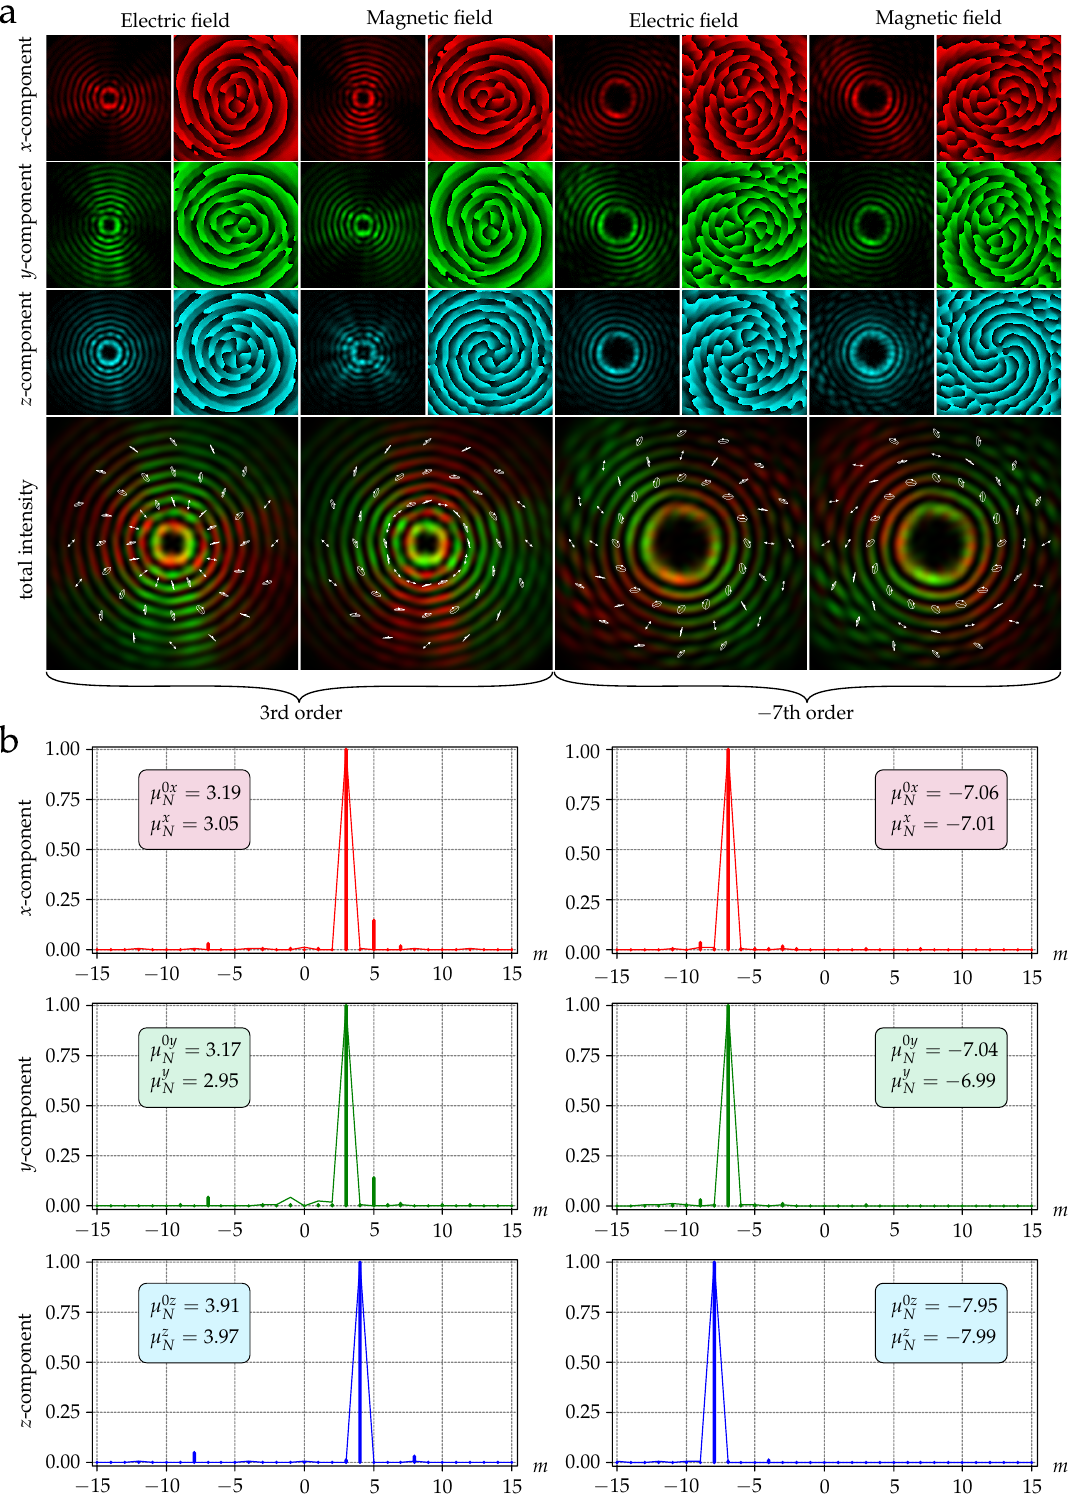
Figure 9. ( a ) Distribution patterns of the emitted fields in far-field. The size of the field plots is 2 mm × 2 mm. ( b ) Normalized intensities of the expansion coefficients in the basis of angular harmonics (OAM spectra) of the components of the electric field 1 (left column) and field 2 (right column): for (cid:12) (cid:12) 2 (vertical lines) and for far-field (cid:12) the incident field (cid:12) c 0 t m (cid:12)